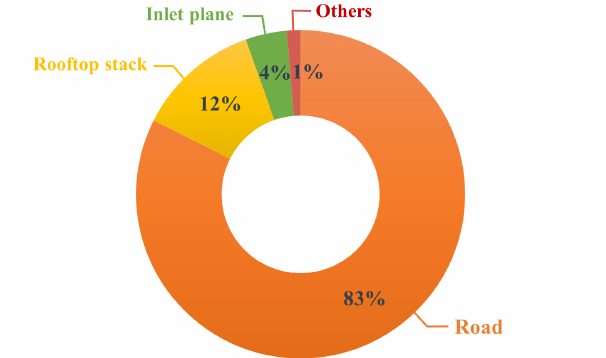
Figure 13. Types of emission sources in the investigated publications.